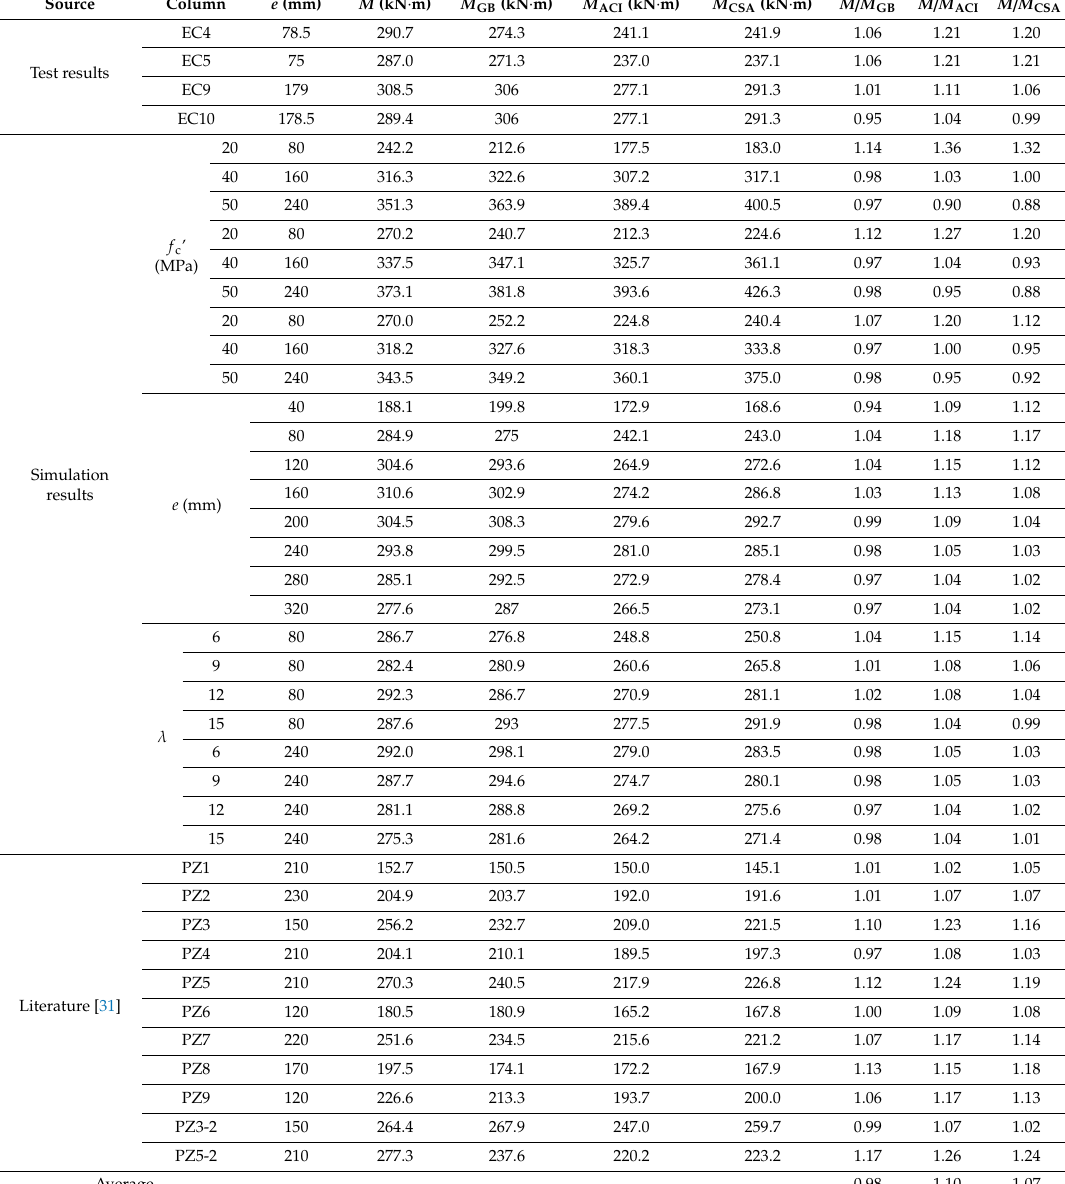
Table 5. Experimental and theoretical bending moment capacity of the